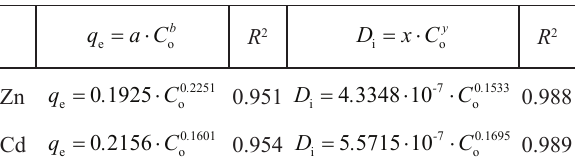
and D as a function of C e i